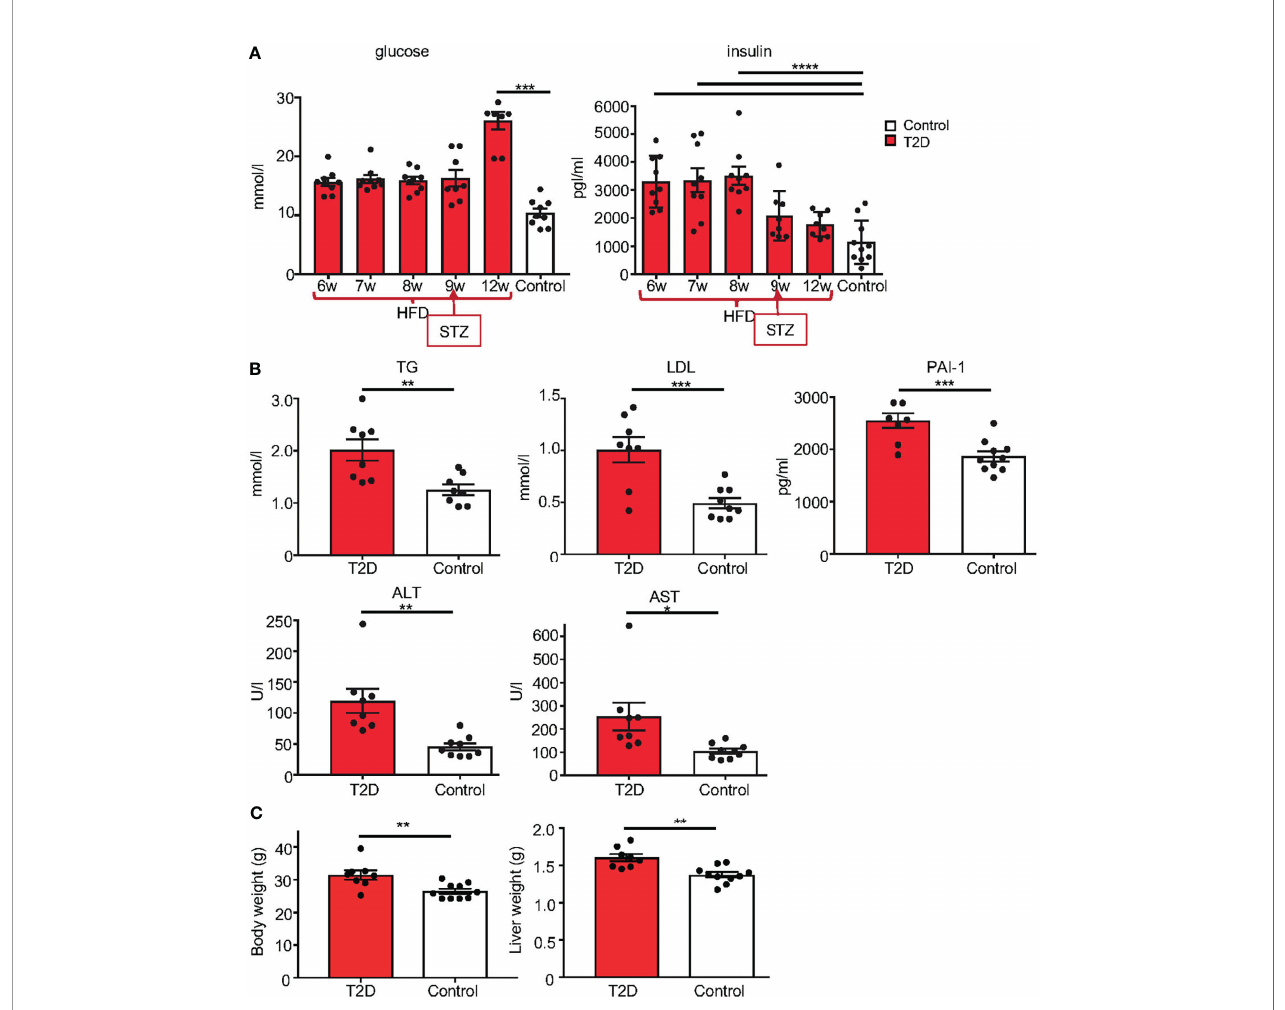
FIGURE 3 | Metabolic phenotype of T2D mouse model. (A) Temporal changes in fasting plasma levels of glucose and insulin in T2D males compare to the average level of male controls. Differences were tested by one-way ANOVA with Tukey ’ s multiple comparisons test. (B) Fasting plasma levels of TG, triglycerides; LDL, low- density lipoprotein; marker of insulin resistance, PAI-1, plasminogen activator inhibitor 1; ALT, alanine aminotransferase; and AST, aspartate aminotransferase, in T2D males compared to controls at 12 weeks of age. (C) Body and liver weight. Data are presented as the mean ± SEM. Differences between groups were tested by t -test (GraphPad Prism 7.0). Differences in liver weight between groups were tested by ANCOVA with body weight as covariate (Ancova – STATISTICA 7.0). *P < 0.05, **P < 0.01, ***P < 0.001, ****P <